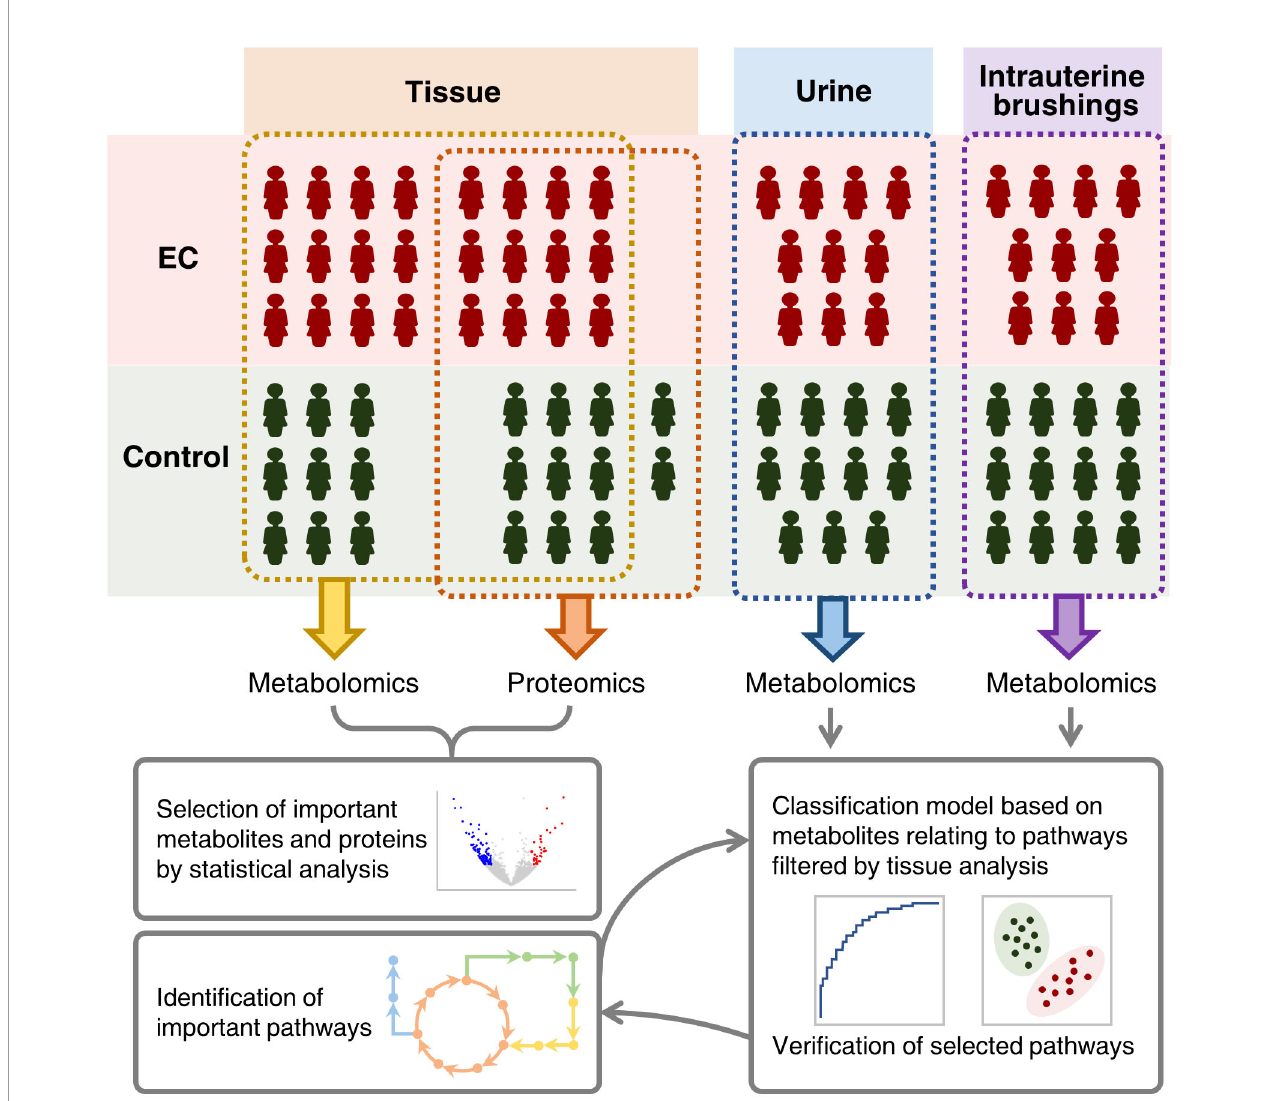
FIGURE 1 | Schematic illustration of integrating metabolomic and proteomic characterization of multi-biosamples from endometrial cancer patients to identify and verify metabolomic pathways signi fi cant to the pathogenesis of endometrial